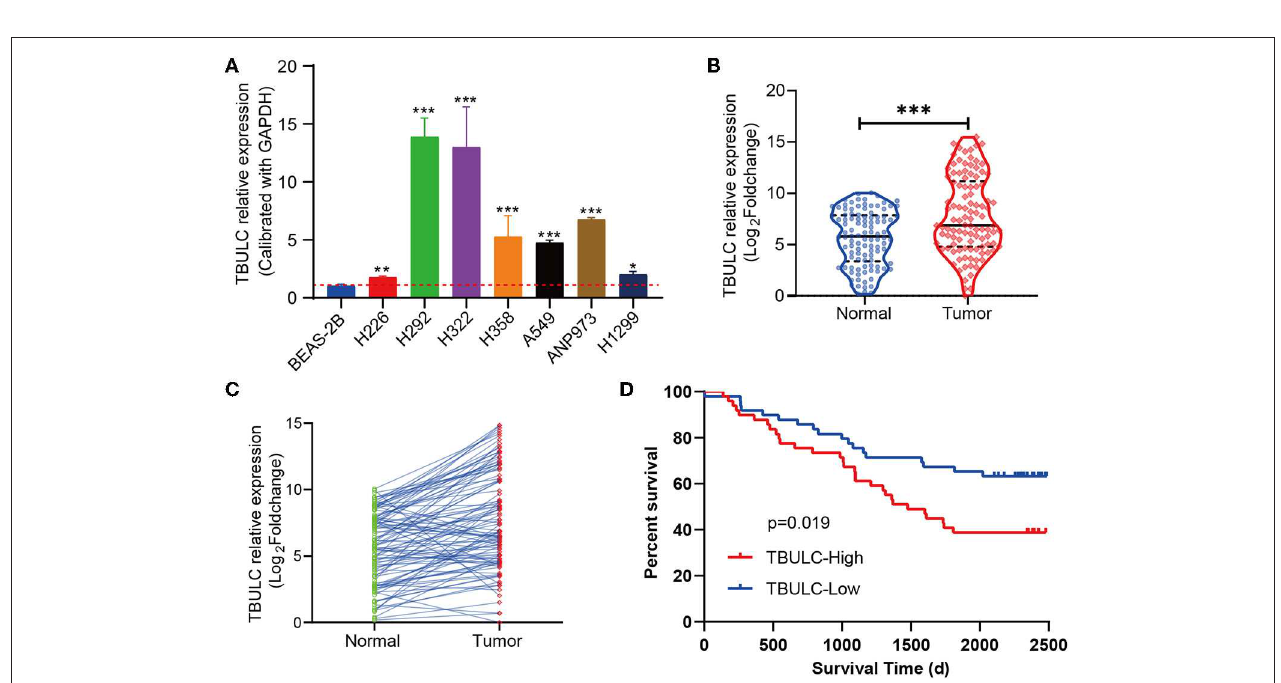
FIGURE 3 | cell clones, as well as that of mock vehicle control-transfected cells, as detected by the Transwell assay. The numbers of migrating and invading cells were compared between the groups. (E) Representative images of lung tissues isolated from mice injected with 1 × 10 6 A549 and H226 cell clones via the tail vein and hematoxylin and eosin-stained images (40 × ) of such tissues. Red arrows indicate the tumor nodules in the lungs. (F) The number of metastatic nodules in the lungs. (G) Relative expression levels of N-Cadherin, Slug, and Ras by Western blot in TBULC-overexpressing A549 and H226 cells. Tubulin was used as a loading control. The data are shown as the mean ± SD, *** p < 0.001.